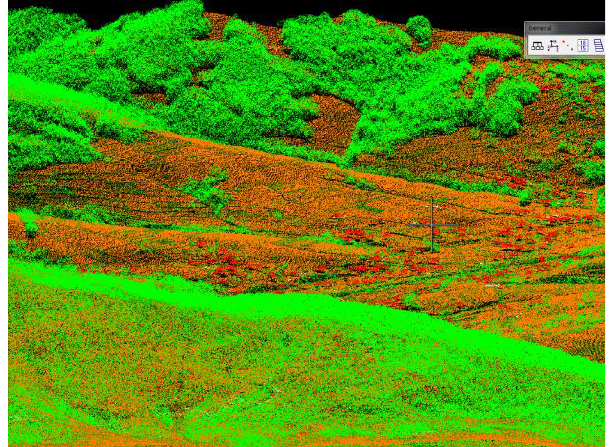
Figure 10. Final version of the classified cloud of points .